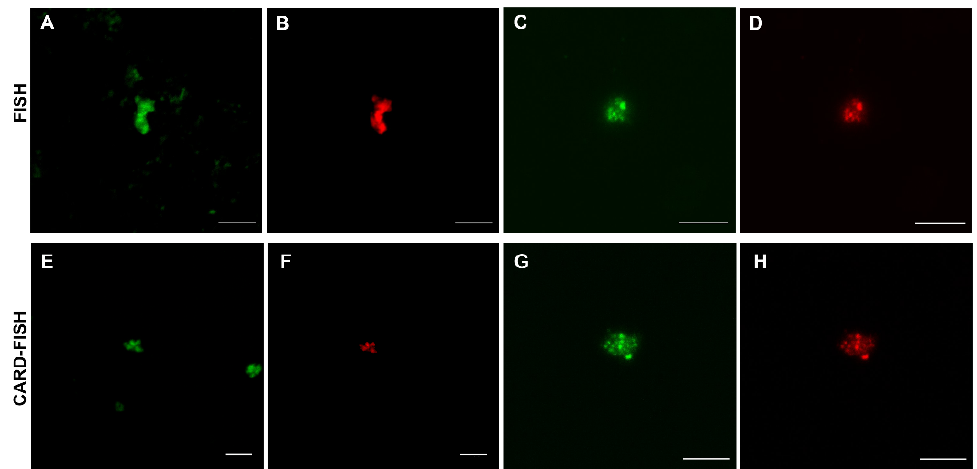
Figure 2. Archaea of the Methanosarcinales order inhabiting the Dallol geothermal system detected by FISH ( A – D ) and CARD-FISH ( E – H ). ( A , B ), Yellow Fumarole (D6); ( C , D ), ponds formed around the Green Pools (D7); ( E , F ), Blackish White/Grayish Fumarole (FNA-1); ( G , H ), Iron Dark Lake (D8). In green, DNA stain. In red, MSSH859 probe signal. Scale bars, 5 µm.